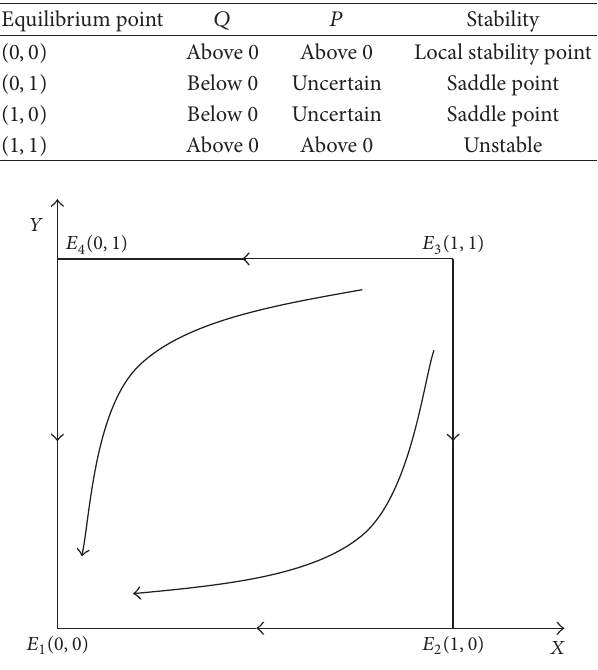
Figure 2: Situation 1: 𝛼𝐴 + 𝛽𝐵 < 𝑐 1 , (1 − 𝛼)𝐴 + (1 − 𝛽)𝐵 < 𝑐 2 .